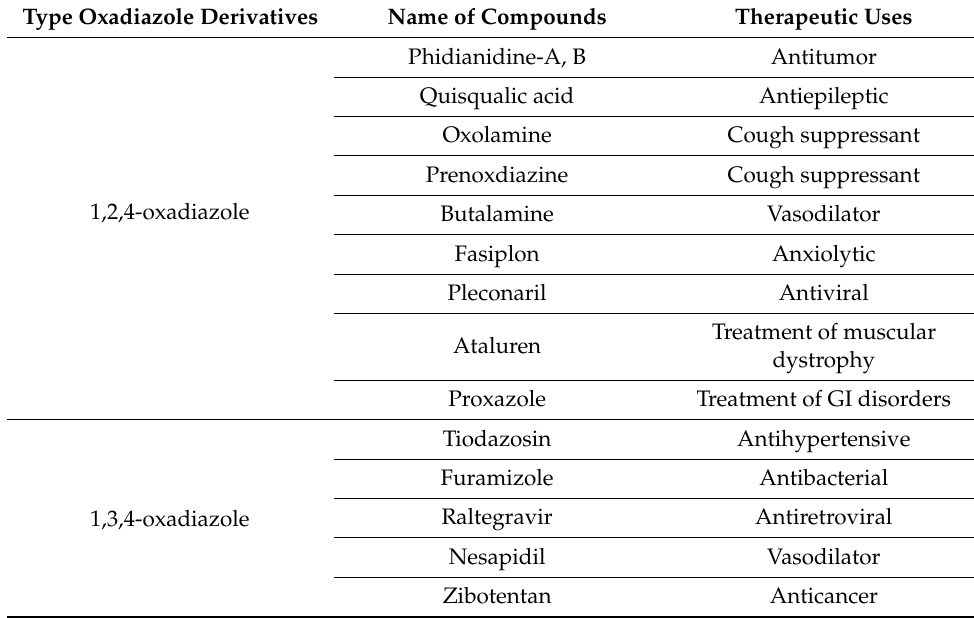
Figure 5. Structure of clinically useful drugs containing 1,3,4-oxadiazole scaffold. Table 2. Therapeutic potentials oxadiazole derivatives.